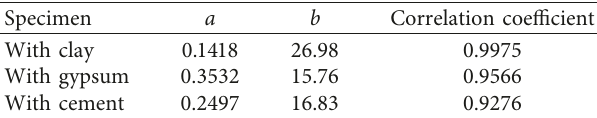
Table 3: The fitting coefficients in the relationship between initial permeability and initial